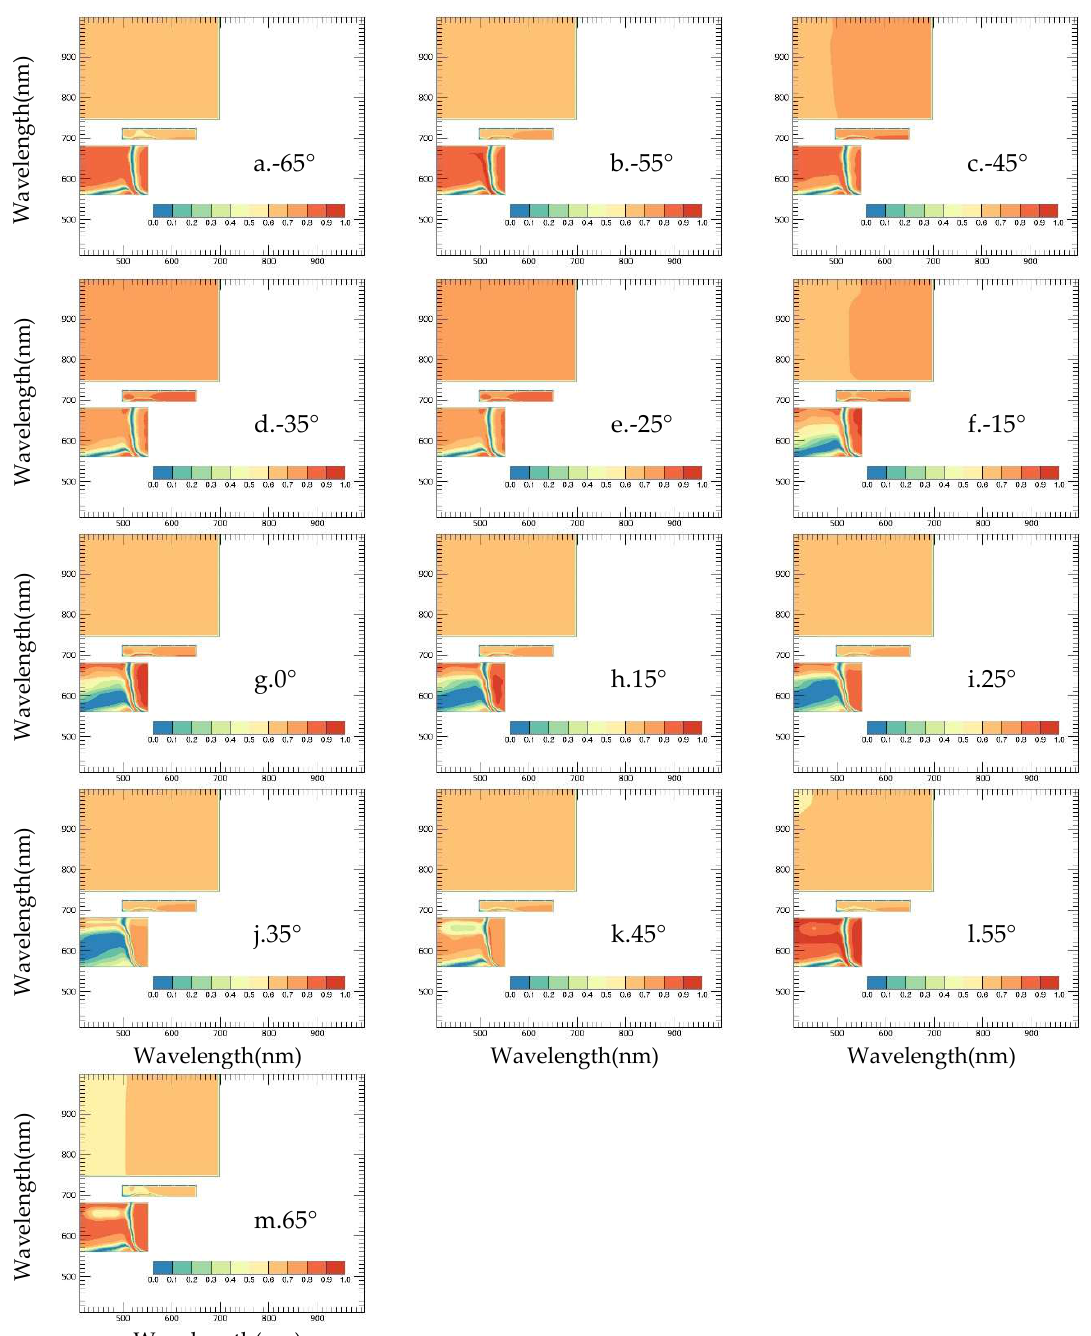
Figure A3. Contour maps of R 2 between NDSI(x,y) and LAI for thirteen VZAs in PP for the planophile variety based on PROSAIL simulations. Subtitle a.-m. shown in each graph denotes observation angle.